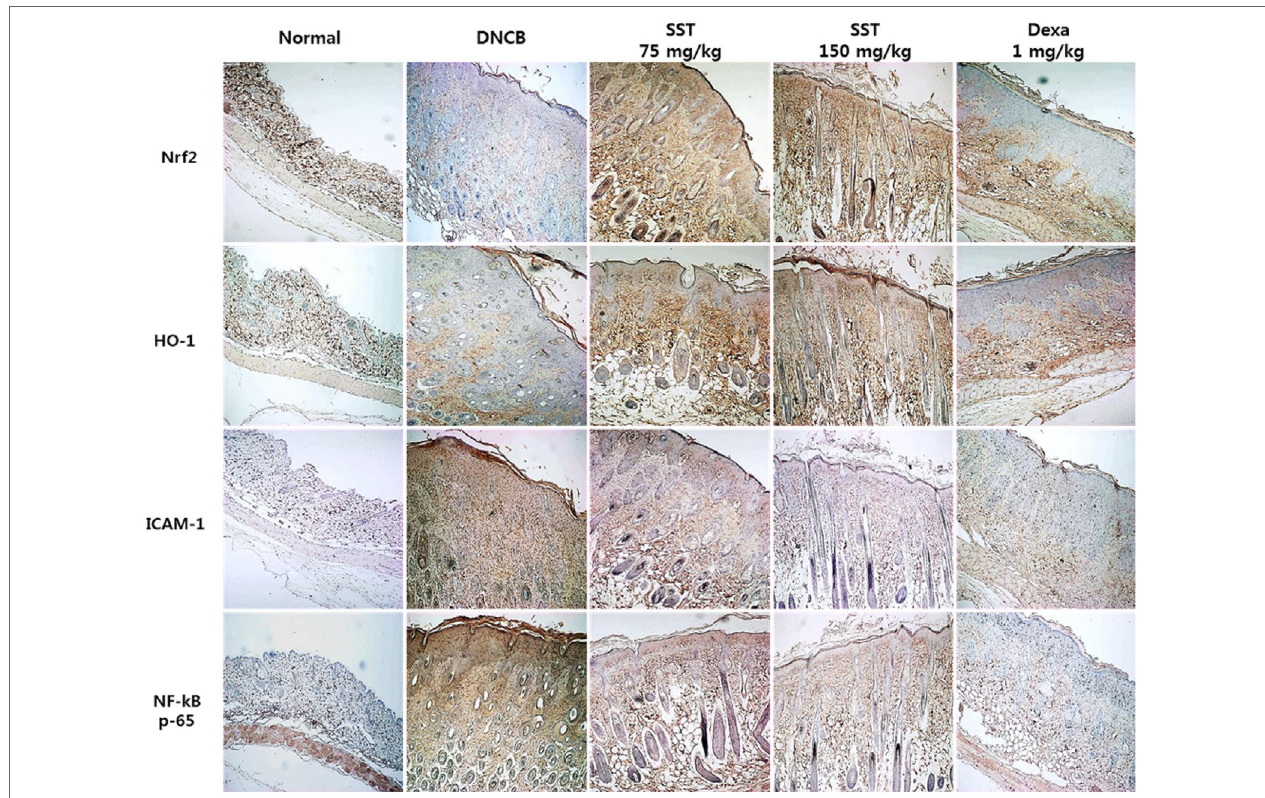
FIGURE 8 | Effects of SST on AD-related factors in DNCB-induced skin tissue. Nrf2, HO-1, ICAM-1, and NF- κ B expression levels in the dorsal skin tissue were analyzed by immunohistochemistry (IHC) staining using anti-Nrf2, anti-HO-1, anti-ICAM-1, and anti-NF- κ B antibodies. Images were taken at 100× magnification.